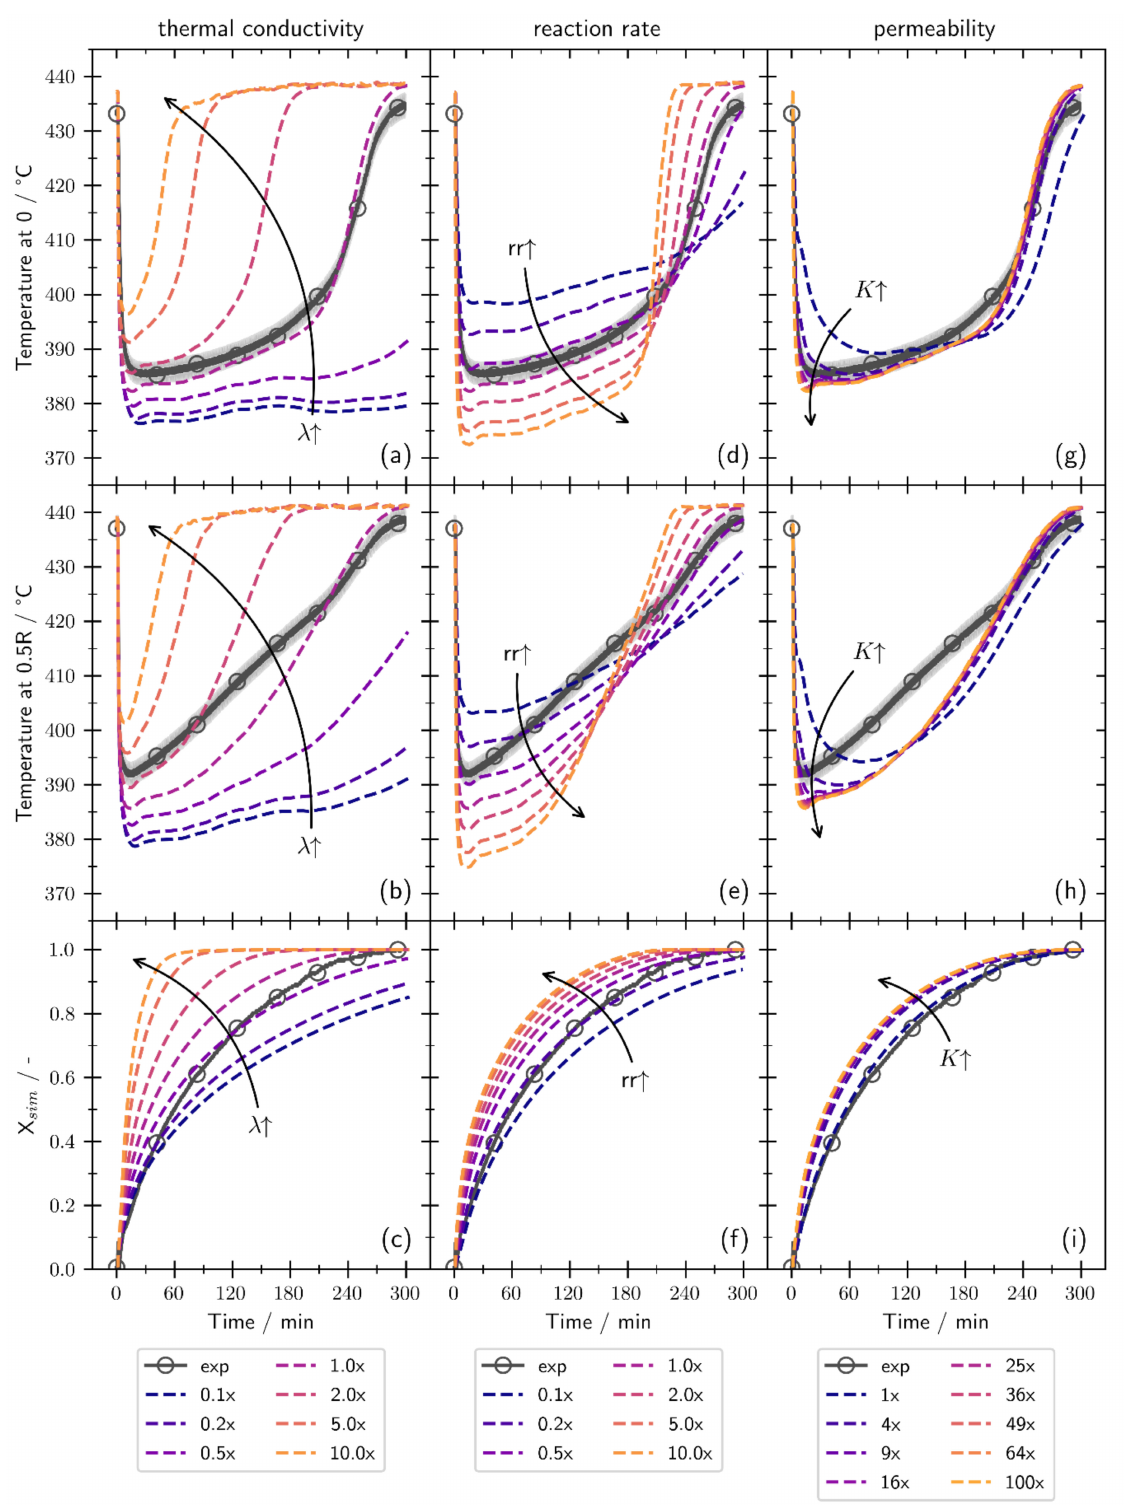
Figure 10. Variation of the thermal conductivity ( a – c ), the reaction rate ( d – f ), and the particle diameter ( g – i ) for E7. The direction of the arrow indicates increasing